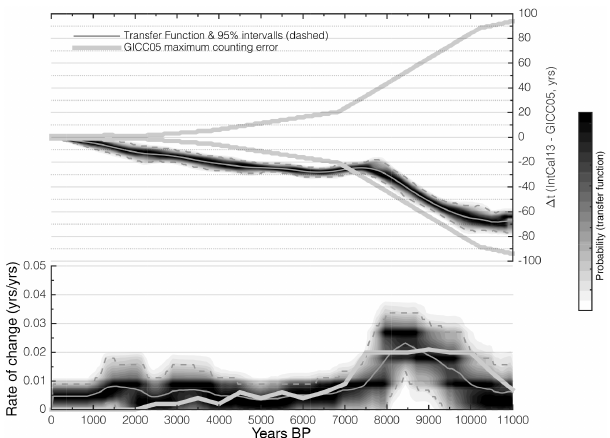
Figure 12. Top: comparison of the derived IntCal13-GICC05 trans- fer function (thin grey lines and shading, dashed lines denote the 95% confidence interval) to the GICC05 maximum counting error (bold grey lines). Bottom: same as above but expressed as the rate of change (yearyear − 1 ) of the GICC05 maximum counting error and the derived timescale transfer